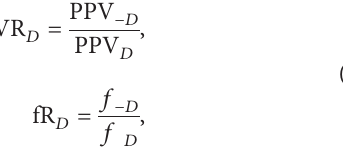
k versus the number of k. k